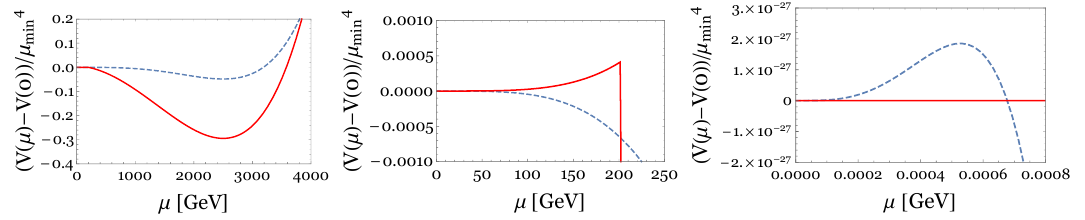
Figure 1 . The radion potential given by eq. (2.23) (red solid curve) for the case of (cid:22) min = 2 : 5 TeV ; (cid:21) = 1 ; (cid:13) c = (cid:25); (cid:11) = 1 ; N = 5 and N H = 3 ( m radion ’ 2 : 2 TeV). We also plot the radion potential calculated by the Goldberger-Wise mechanism (blue dotted curve), where we take parameters such that the radion VEV at the potential minimum is the same as ours. In both cases, the kinetic term is given by (2.8). The left, middle and right panels focus on the regions around (cid:22) = (cid:22) min , (cid:22) = (cid:22) c and (cid:22) = 0,